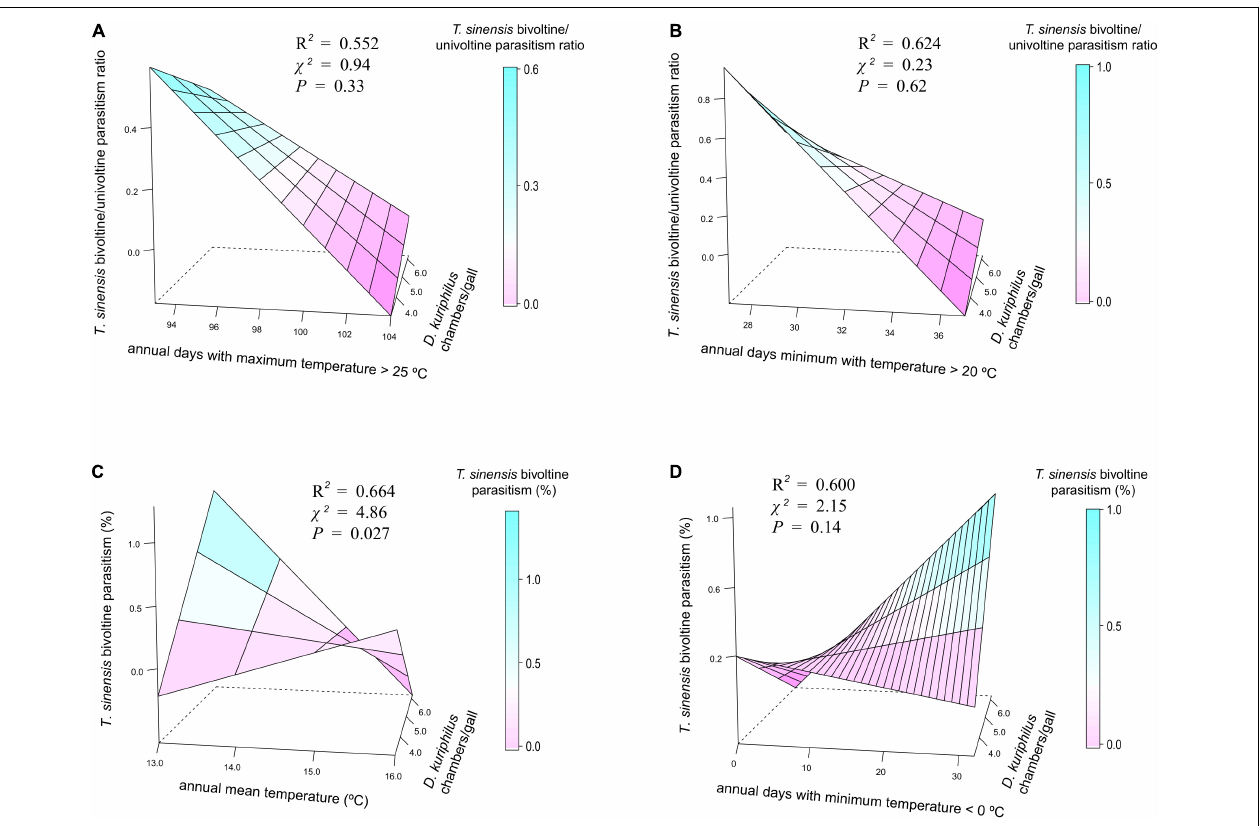
FIGURE 3 | 3D plots showing the joint effect of temperature measurements and D. kuriphilus chambers/gall on (A,B) T. sinensis bivoltine/univoltine parasitism ratio and (C,D) T. sinensis bivoltine parasitism. χ 2 and P -values extracted from spatially explicit regression models; explained variance ( R 2 ) extracted from models without spatial autocorrelation